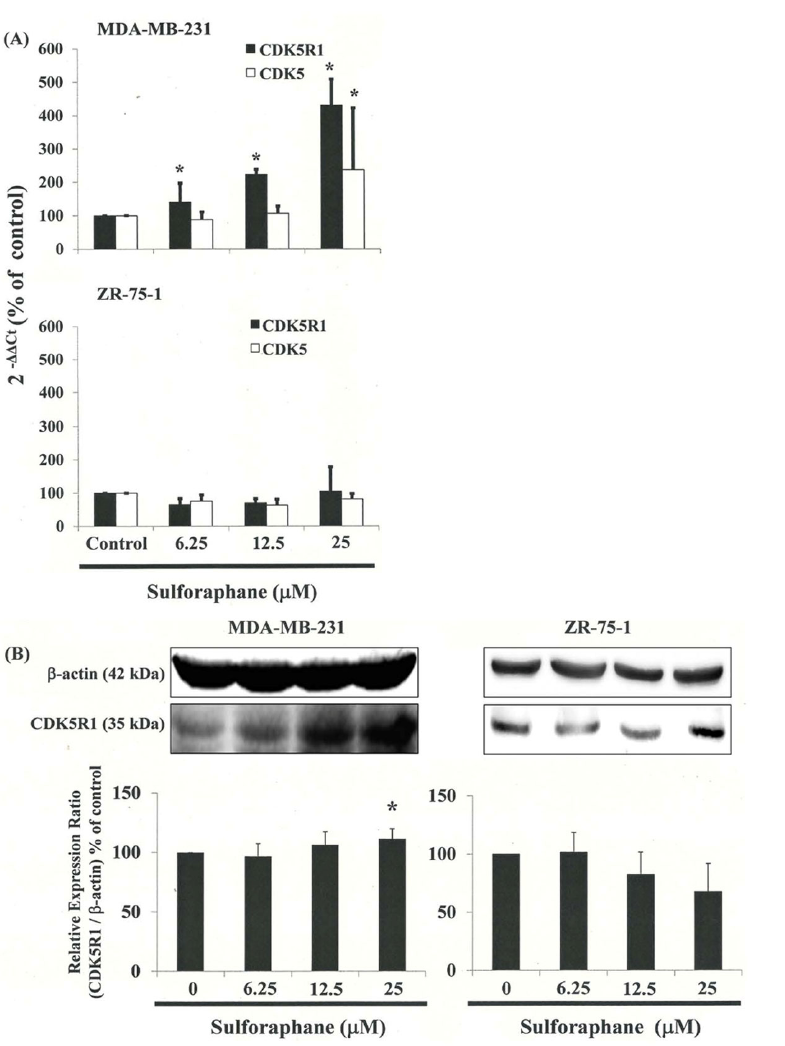
Figure 5. CDK5R1 and CDk5 gene expression in MDA-MB-231 and ZR-75-1 cells following exposure to SFN: ( A ) qPCR and ( B ) Western blotting analysis of CDK5R1 and CDk5 gene expression standard- ized against the levels of GAPDH or β -actin in cancer cell lines exposed for 4 h to DMSO (SFN 0 M control) or SFN. * in each group of bars indicates that the difference resulting from treatment with 0 ì M SFN was significant at p < 0.05. All data are reported as the mean ( ± SEM) of at least three separate experiments.